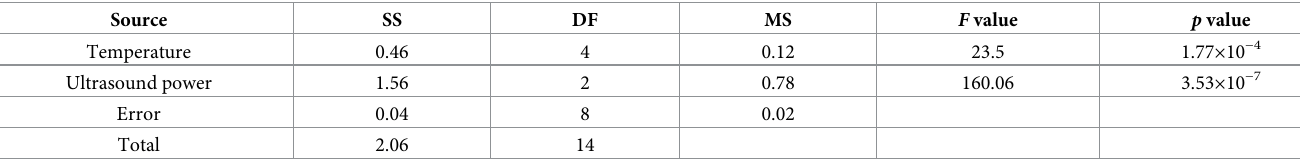
Table 3. Analysis of variance for energy